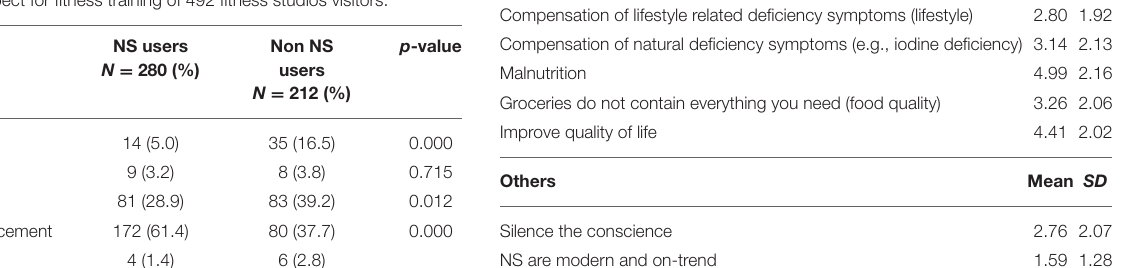
TABLE 2 | Main aspect for fitness training of 492 fitness studios